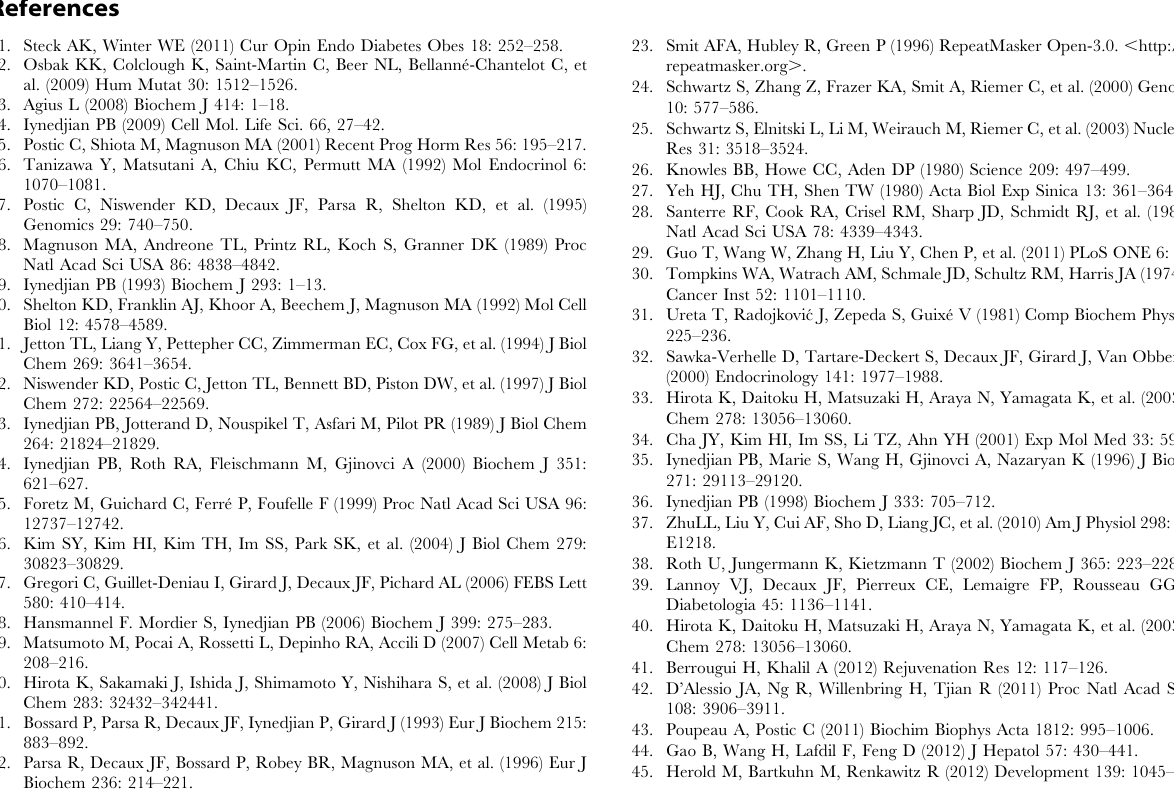
Table S2 Primers used for the RT-PCR analysis of gene expression in HepG2 and L-02 cell lines. Table S3 Sizes of introns (in bp) in mammalian glucokinase genes. Table S4 Number and amount of repetitive DNA elements located between the beta-cell and liver-specific exons of mammalian glucokinase